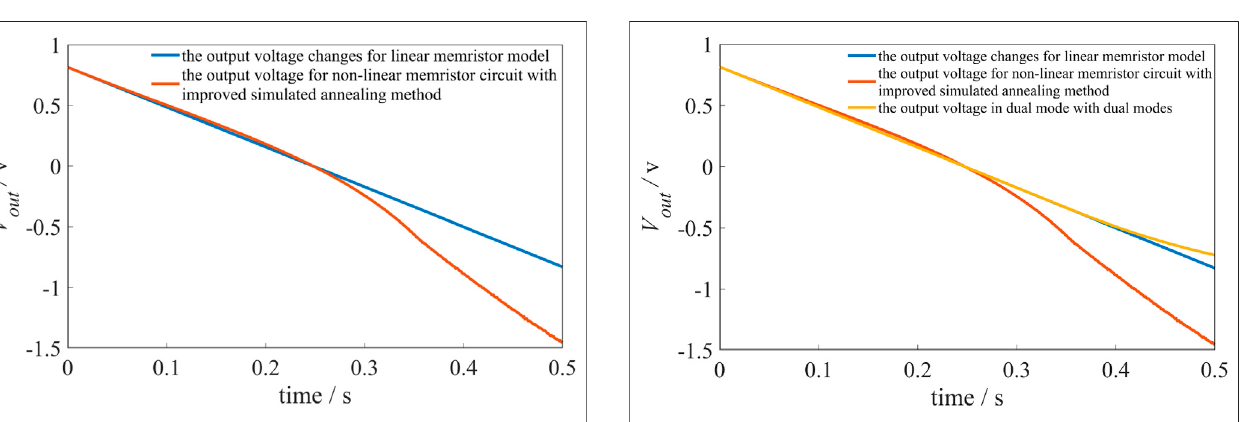
FIGURE 8 | The comparison of output voltages for linear memristor circuit (the blue line), non-linear memristor circuit with improved simulated annealing method (the red line) and with dual modes (the orange